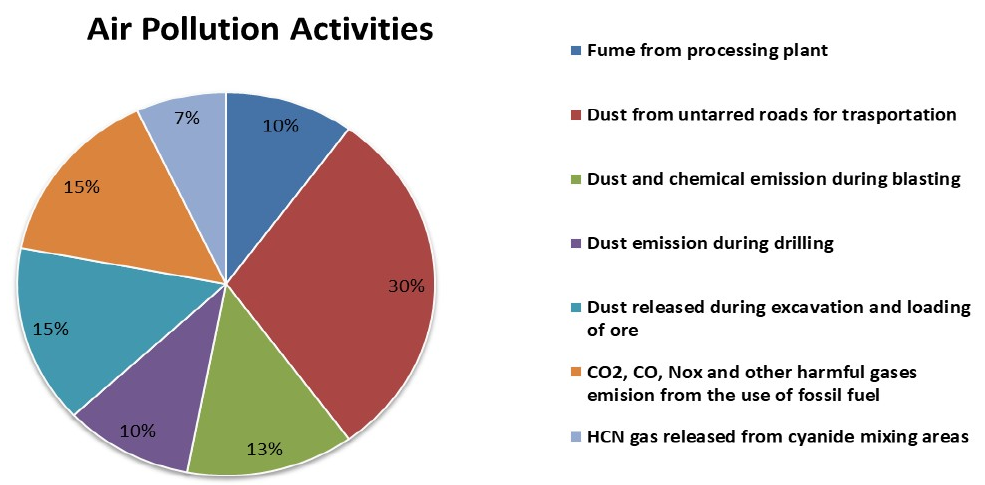
Figure 13. Percentage presentation of air pollution activities (based on data from the District EPA).